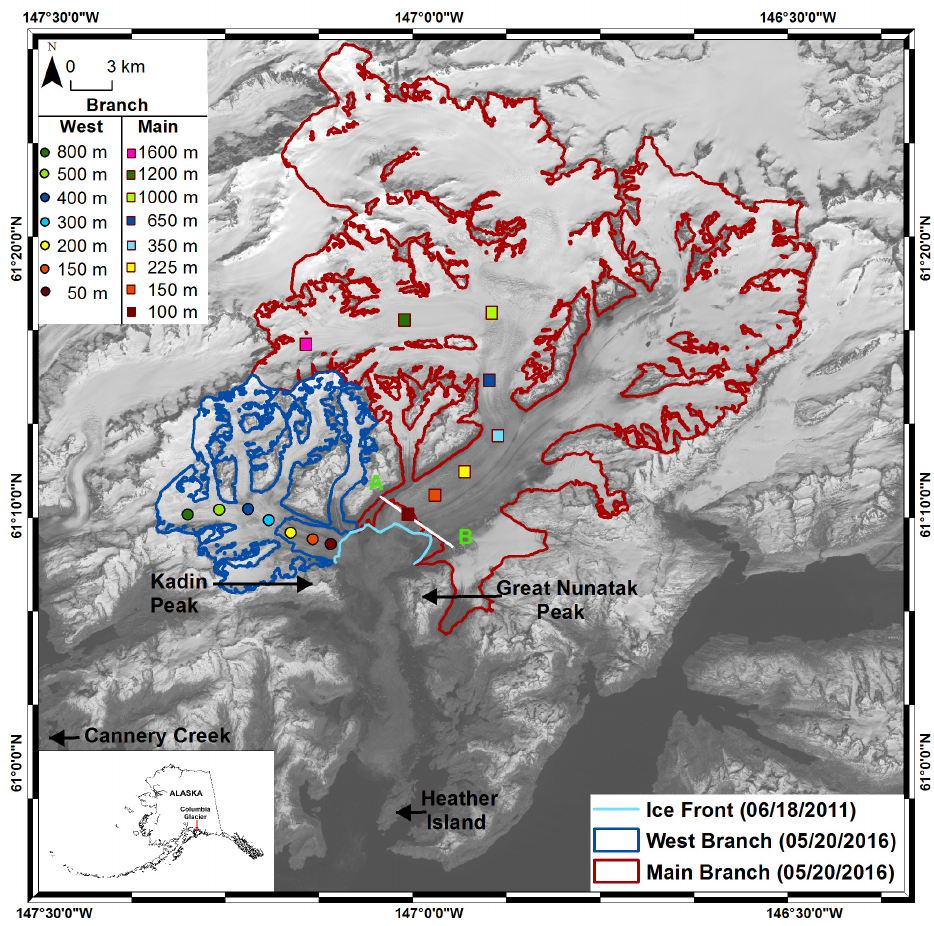
Figure 1. Overview map of Columbia Glacier showing front positions in 2011 and the catchments areas in 2016. Prior to 1980, the glacier extended to the north edge of Heather Island. The flux gate at the main branch is shown as AB through which mass flux was computed. The colored dots denote the subset areas of ~25 × 25 pixels (255 m × 255 m on ground) at different elevations (ref. 06/18/2011 TDX DEM) used to compute averaged values of surface velocity and vertical change in phase center (PC). These subsets are abbreviated as M 100 , M 150 , M 225 , M 350 , M 650 , M 1000 , M 1200 and M 1600 for